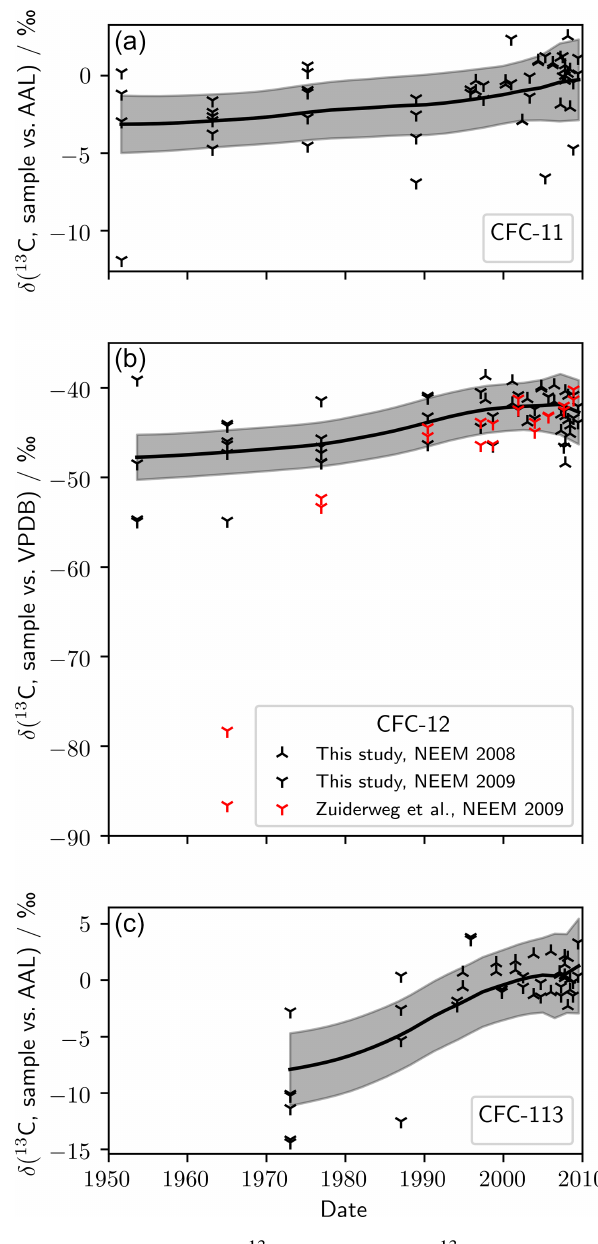
Figure 2. (a) Measured δ ( 13 C, CFC-11), (b) δ ( 13 C, CFC-12), and (c) δ ( 13 C, CFC-113) in NEEM 2008 and 2009 firn air. Also shown is δ ( 13 C, CFC-12) as measured by Zuiderweg et al. (2013) in the same NEEM 2009 firn air samples. The smoothed trend (black line) and 95% confidence bounds (grey shading) were generated using a LOESS regression.